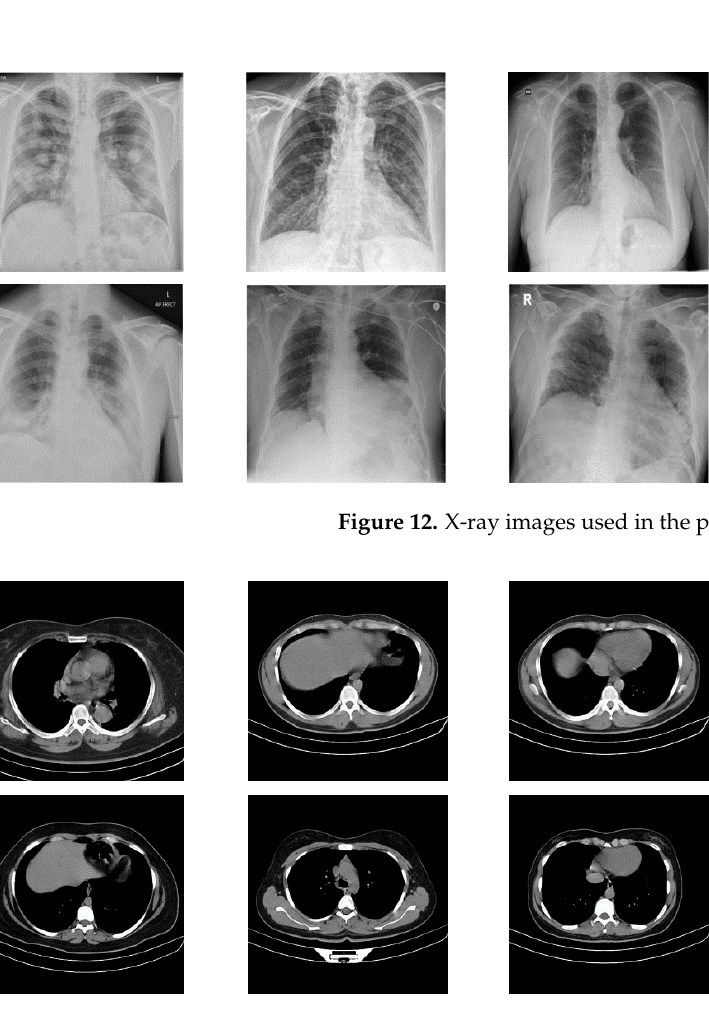
Figure 13. CT images used in the proposed method.